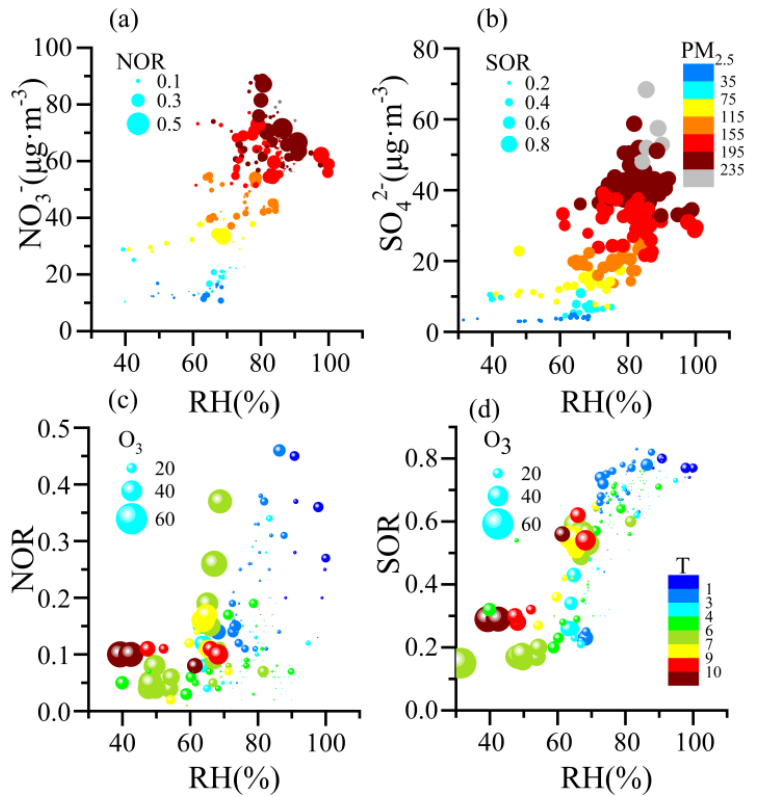
Figure 4. Correlations between RH with NO 3 − ( a ), SO 4 2− ( b ), NOR ( c ), and SOR ( d ). Symbols in ( a , b ) are scaled by NOR and SOR and colored by PM 2 . 5 concentration; Symbols in ( c , d ) are scaled by O 3 concentration and colored by temperature (T).